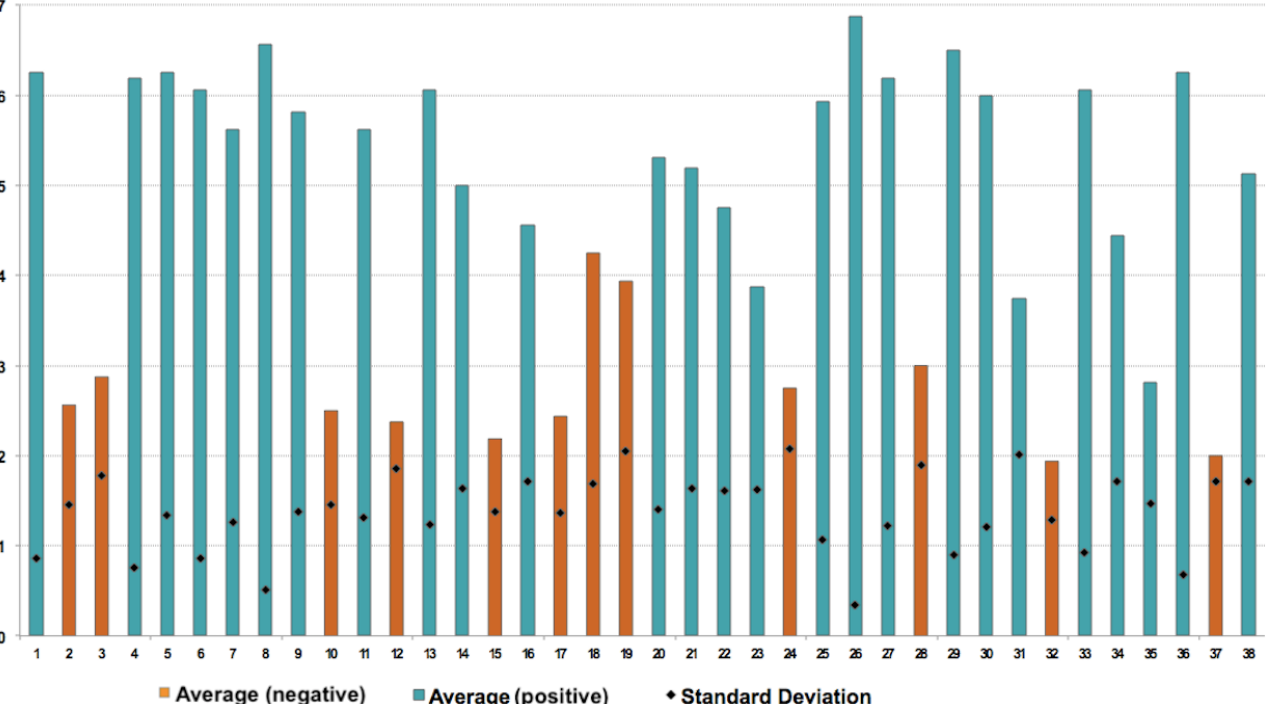
Figure 14. Average results and standard deviations calculated from the CEGE questionnaire by Calvillo-Gámez et al. (2015), for each question answered using a 7-point Likert